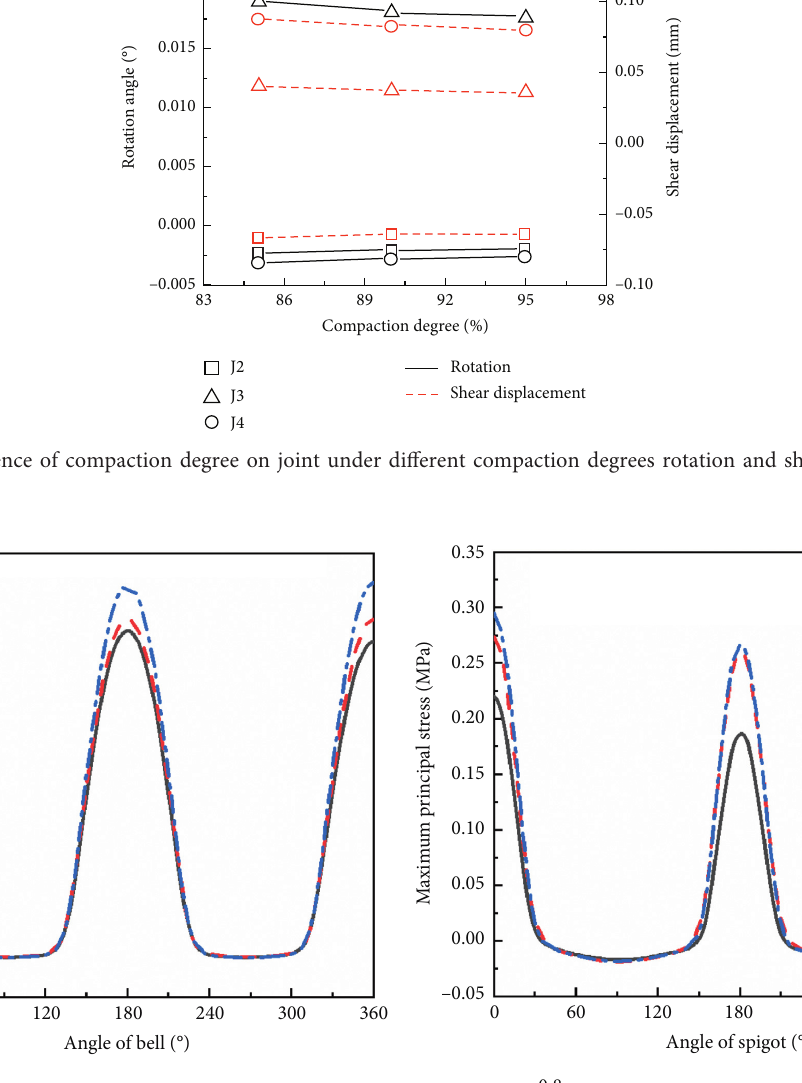
Figure 23: Maximum principal stress of (a) the bell and (b) the spigot under different burial depths.